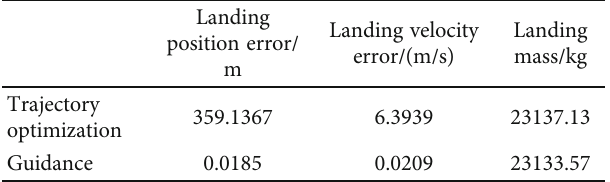
Table 6: Landing errors and masses under the condition that thrust magnitude has deviations.